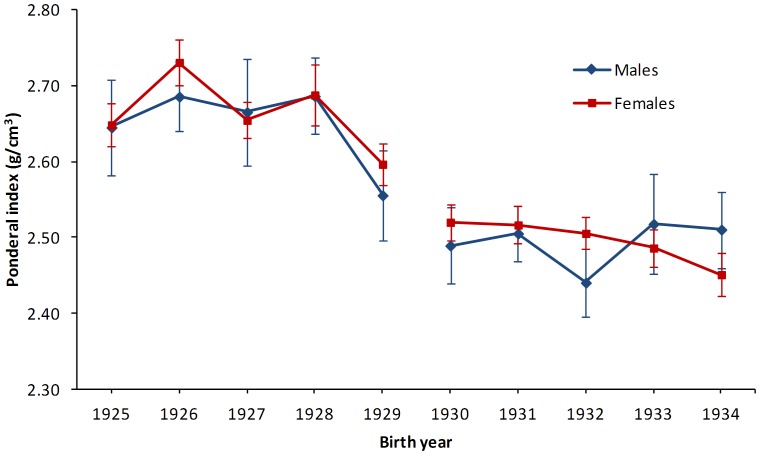
Yearly ponderal indexa for men (diamond) and women (square) born between 1925 and 1934.Footer: Data are shown as means and the bars denote the standard error of the means. Ponderal index is further stratified by sex and grouped by birth during pre-Depression (1925–1929) and during the Depression (1930–1934). a Ponderal index = (birth weight in g/birth length in cm3*100).